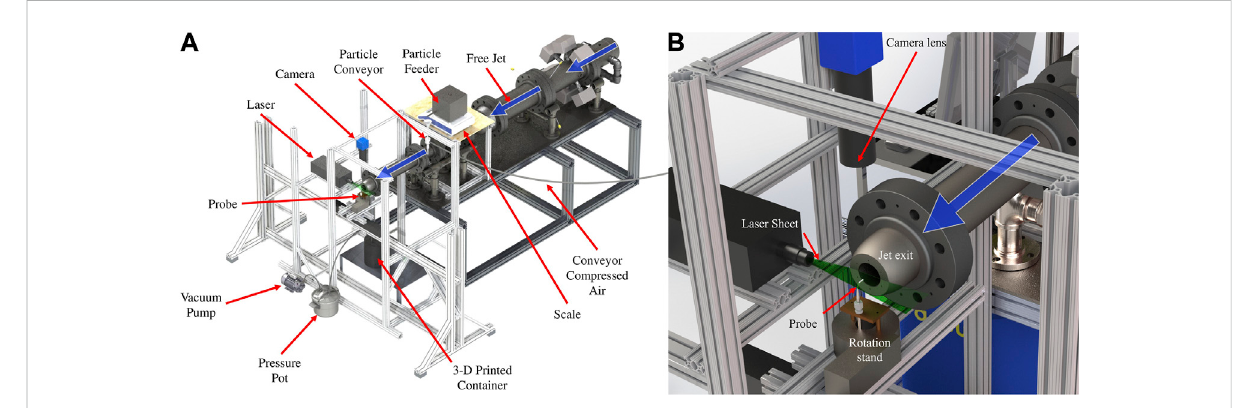
FIGURE 4 Virginia Tech Free Jet rig (A) and detailed perspective of probe experiment setup (B) .